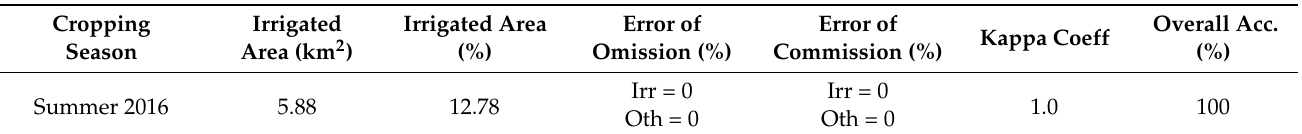
Table 4. Classification accuracy of intensively irrigated cropland (Irr; intensive irrigation) and other croplands (Oth; rainfed, fallow, and partial irrigation in the absence of rainfall) for 2016.